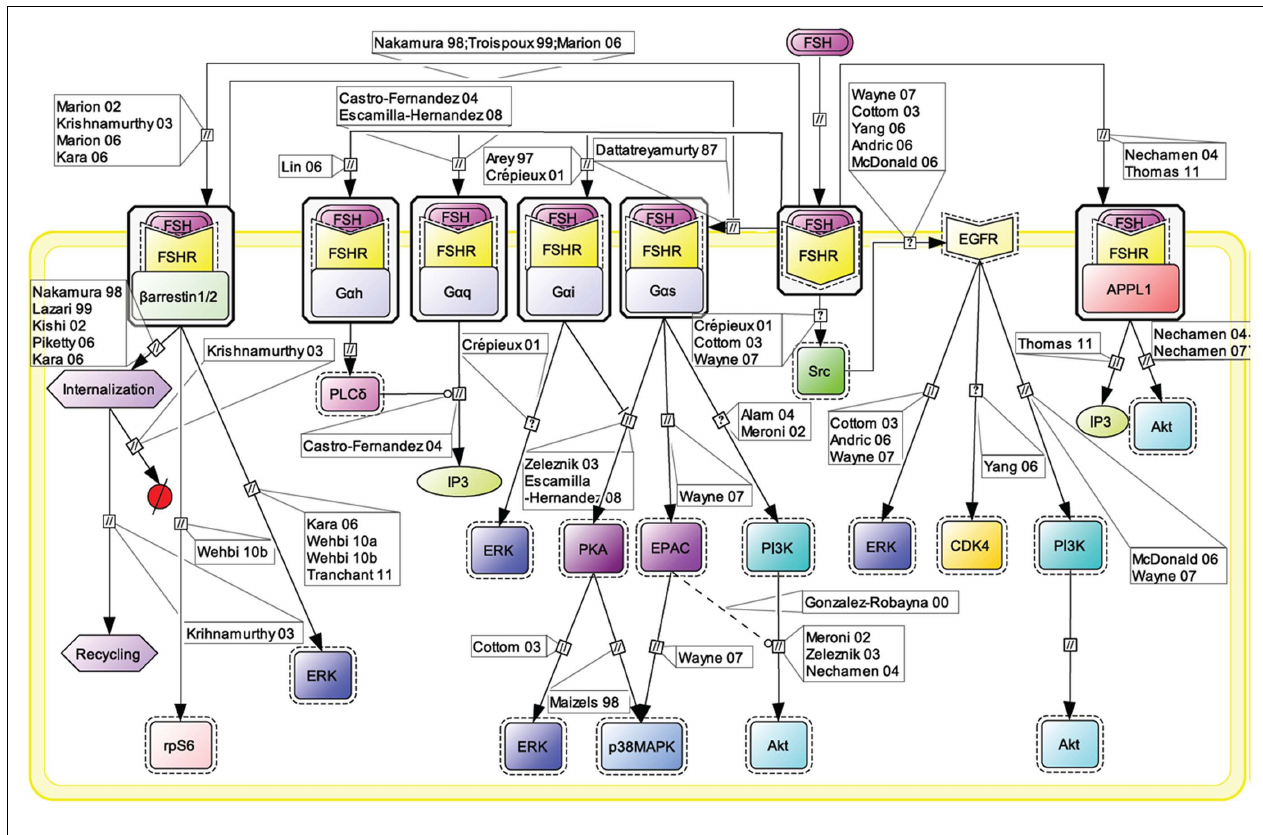
FIGURE 1 | Multiple transduction mechanisms induced at the FSHR. The G α s/cAMP/protein kinase A (PKA) signaling pathway has classically been considered as the key signaling mechanism triggered at the FSHR. Over the last decade, mounting evidence have shown that FSHR also engages other transduction mechanisms mainly coupling to other G α subunits, β -arrestin-dependent signaling, EGFR transactivation, and APPL1-mediated signals. Bibliographic references are indicated on the map by the first author’s name with two digits for the year of publication.The